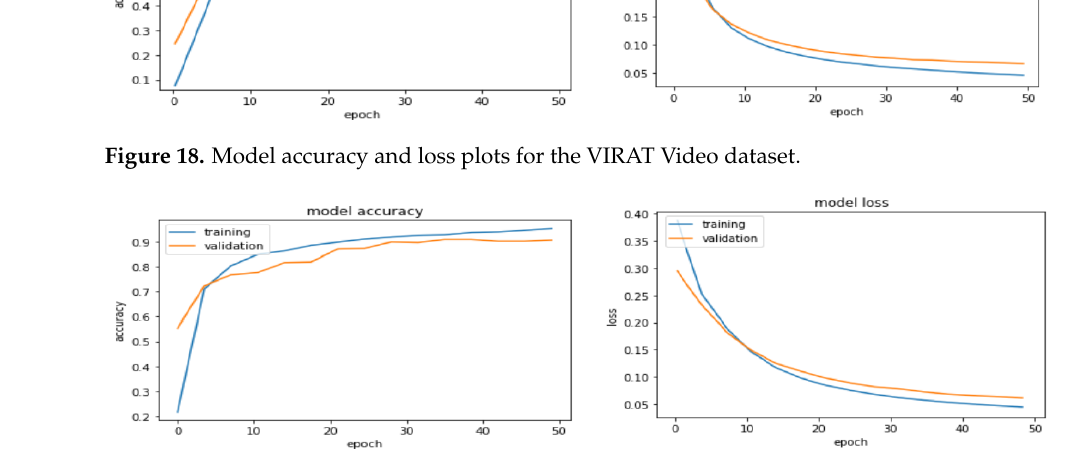
Figure 19. Model accuracy and loss plots for the YouTube Aerial dataset.